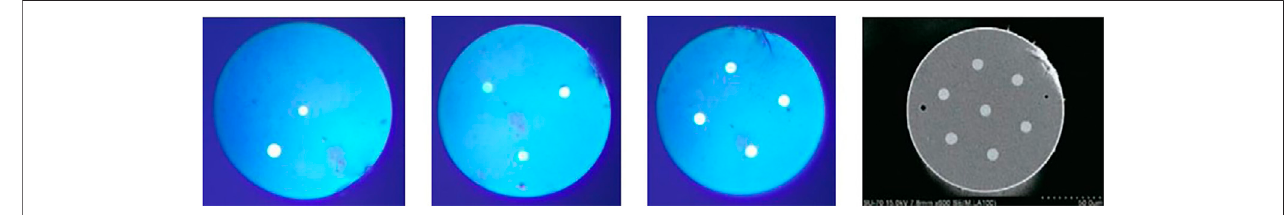
FIGURE 11 | From left to right: Two-core fi ber, three-core fi ber, four-core fi ber, seven-core fi ber [52].